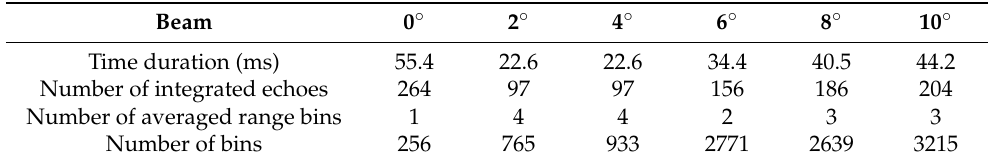
Figure 1. SWIM beam rotation with incidence angles. ( a ) Schematic of the illumination geometry formed by the six beams during three macrocycles. One macrocycle comprises the illumination patterns formed by the six successively transmitted beams; these are not continuous in azimuth. ( b ) SWIM footprint distribution in the Arctic on 15 April 2020. ( c ) Schematic, using geographical coordinates, of a portion of the Earth’s surface sampled during approximately several macrocycles. Antenna aperture: 2 ◦ × 2 ◦ . Table 2. SWIM nominal macrocycle parameters (sequential illumination of beams 0° to 10° in increasing order) and associated real-time processing parameters [35].